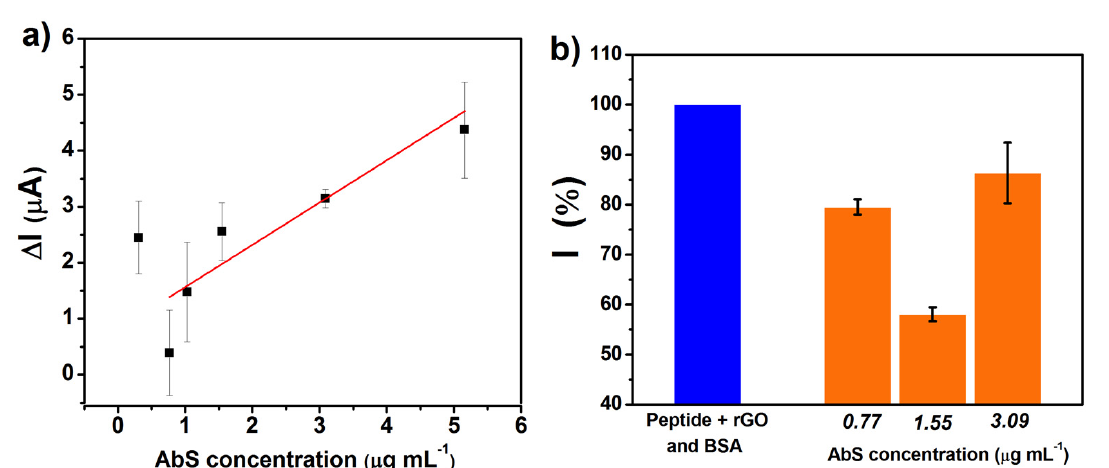
Figure 4. ( a ) Analytical curve obtained through probe current peak intensity vs. antibody concen- tration ( n = 3, ± SD) on 0.1 mol L − 1 PBS, pH 7.4. ( b ) Summarized DPV assays for negative human serum spiked with different AbS concentrations ( n = 3, ± SD). Table 1. Electrochemical biosensors applied in the detection of SARS-CoV-2: recognition sites, tech- niques, immunoassay time, and lowest detectable values.